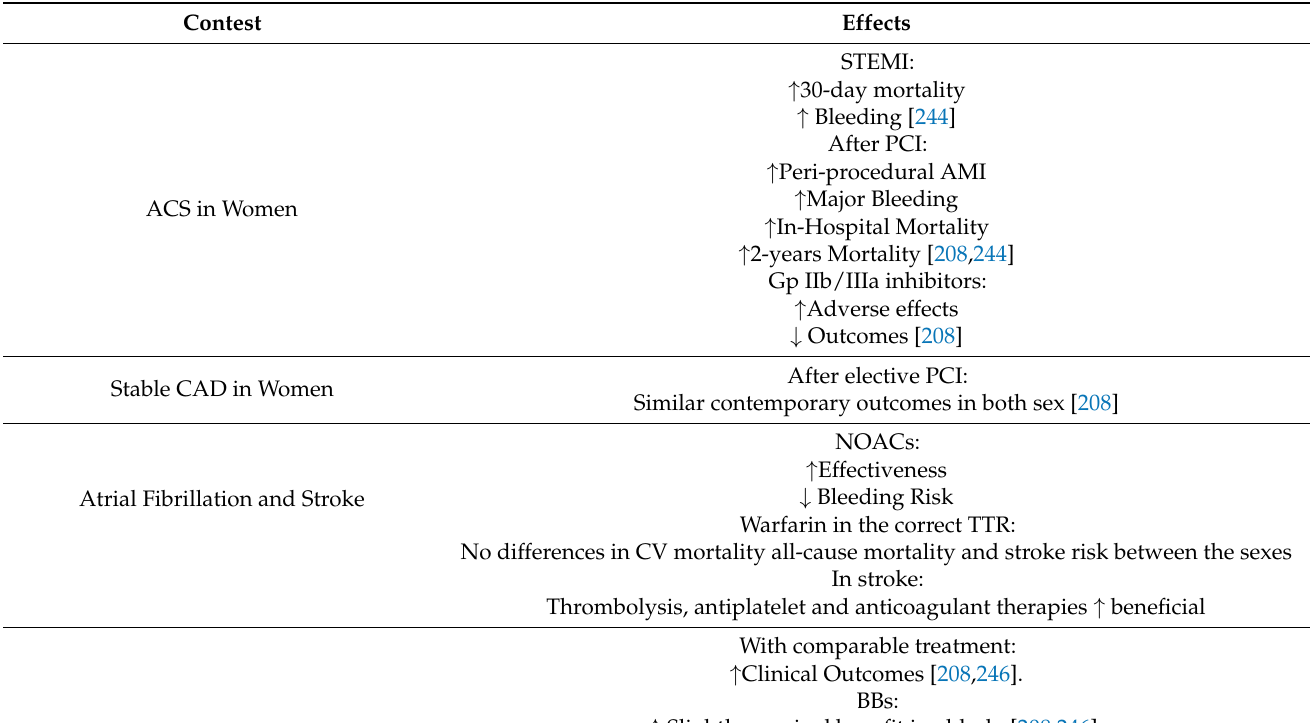
Table 1. Effects of treatment in women on clinical outcomes in different cardiovascular settings compared with